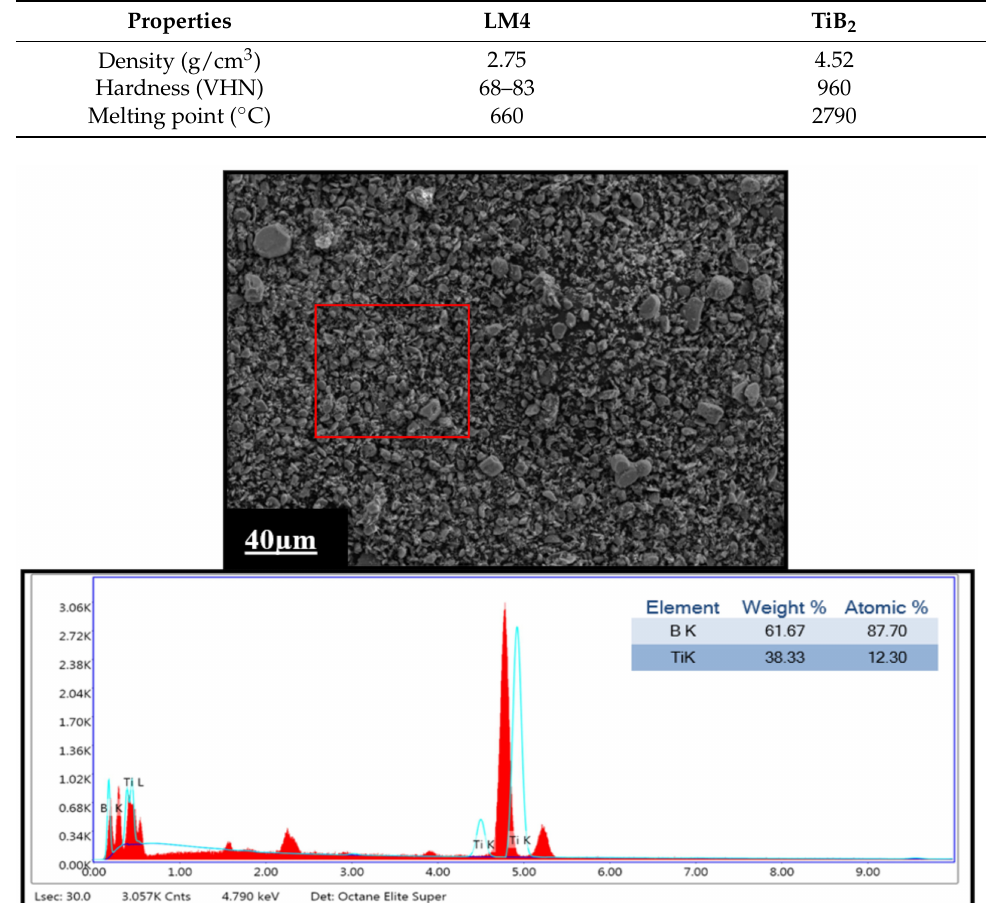
Figure 2. SEM and EDAX of TiB 2 reinforcement